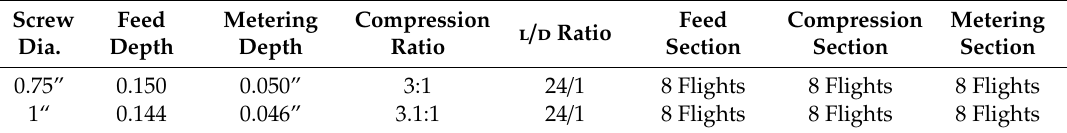
Figure 2. Extrusion Screw Schematic. Table 1. Extrusion screw geometry details for both the 0.75” and 1” screws.